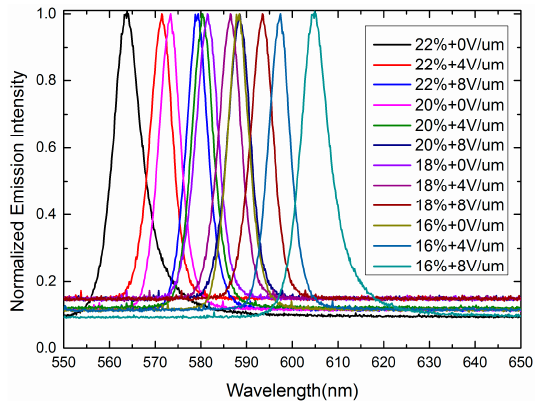
Figure 9. Emission spectra of templated SPLC systems under different electric fields.